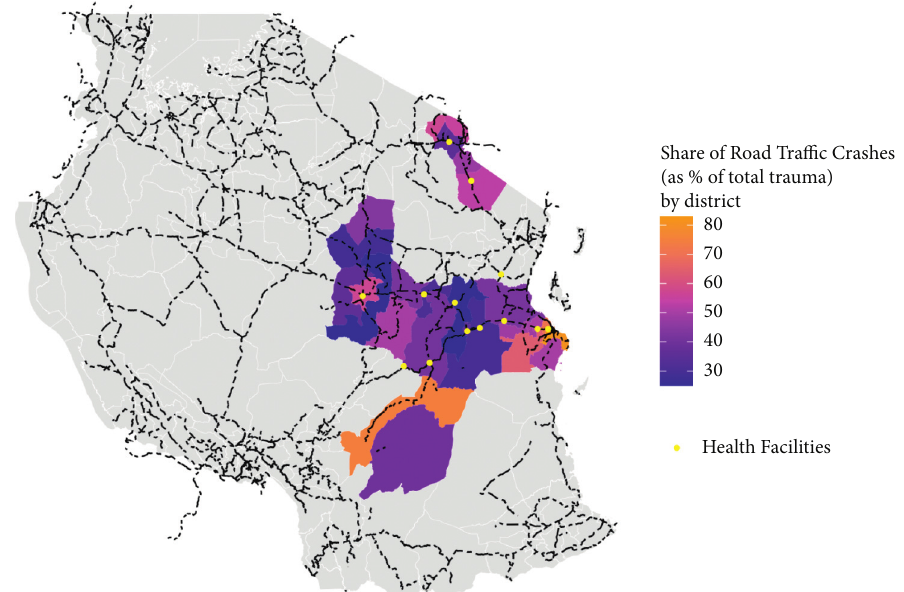
Figure 2: Heat map of accident hotspots ∗ . Note: This map shows road traffic crashes as a percentage share of total trauma in the trauma registry at the district level. The colored region represents 30 districts surrounding the facilities (seen in yellow dots), which were recorded in the trauma registry. Lighter shade represents a higher share of road traffic crashes recorded in a given district. The gray portion refers to other districts in Tanzania, which were not recorded in the trauma registry. The dashed black lines represent the highways and other primary roads in